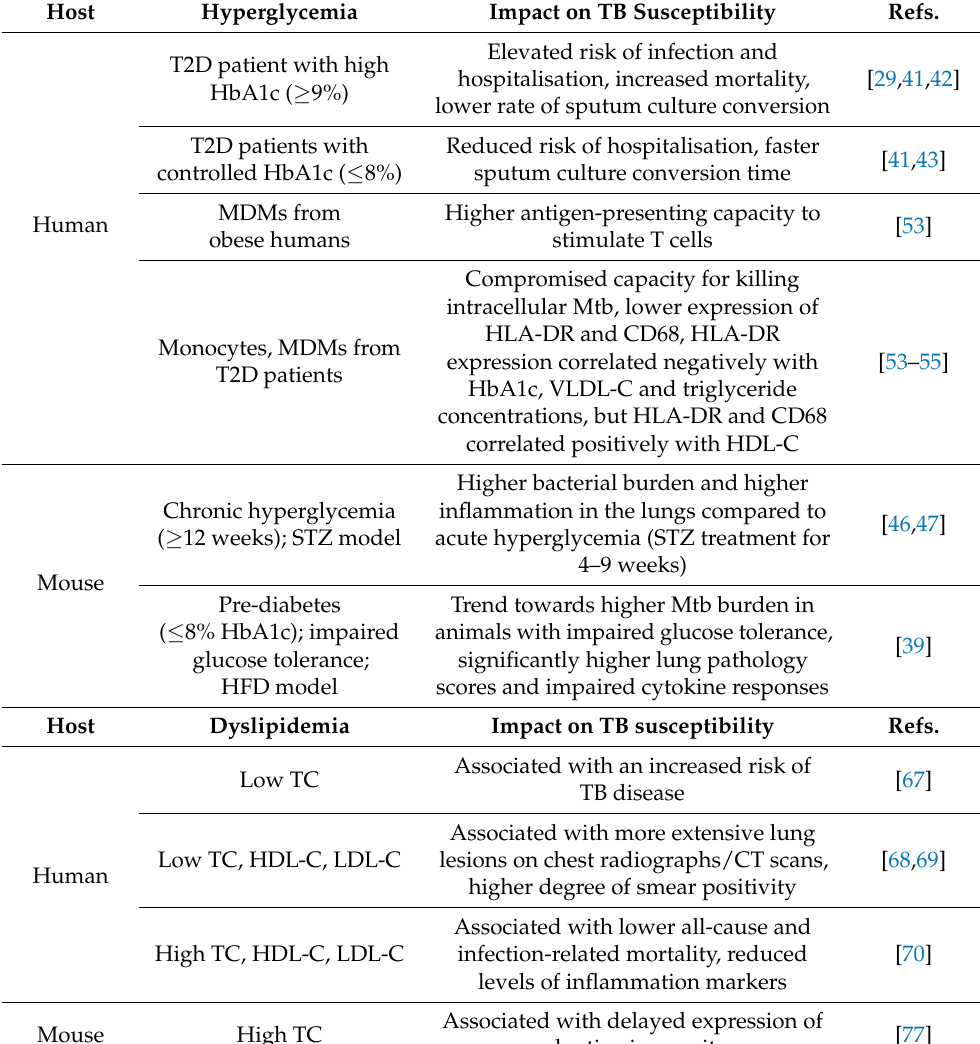
Table 1. Impact of hyperglycemia and different types of dyslipidemia on TB